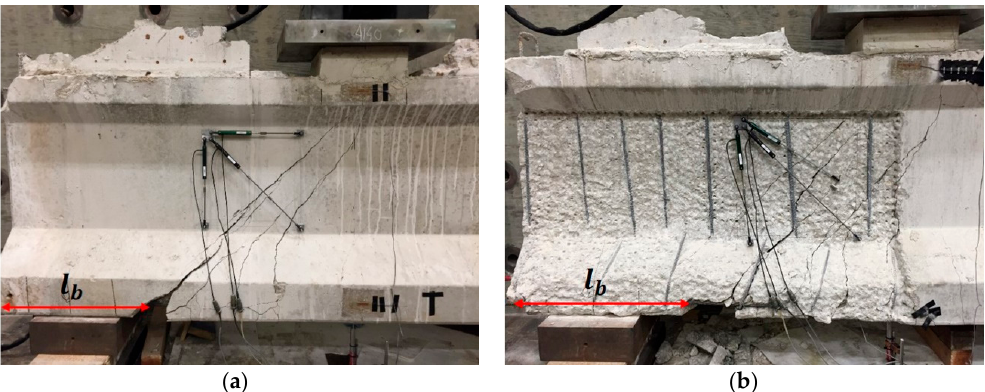
Figure 8. Failure mode of control and damaged specimens (1:27): ( a ) control case after failure and ( b ) damage case after